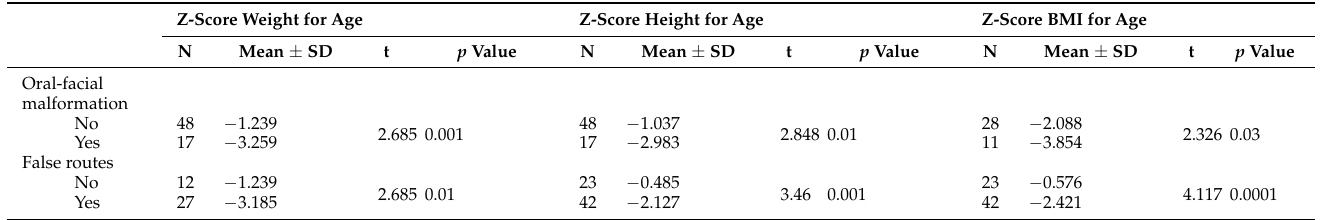
Table 5. Nutritional indices according to oral-facial malformation and swallowing